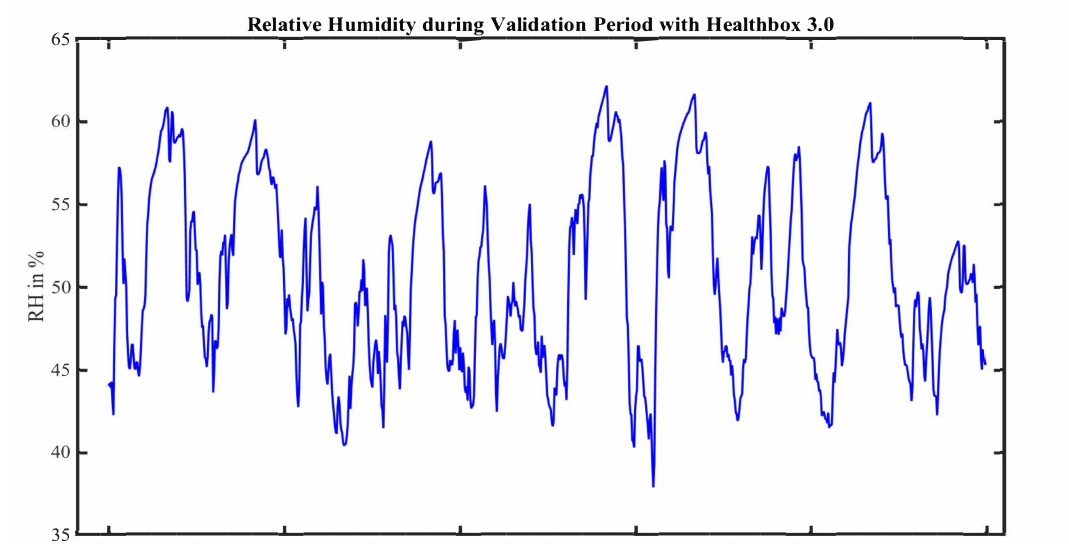
Figure 9. Humidity variations with the hybrid ventilation